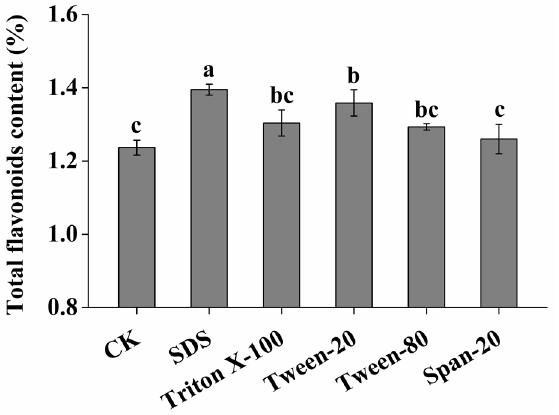
Figure 1. Effects of different types of surfactants on contents of SLPF. Different letters imply significant differences at p < 0.05.